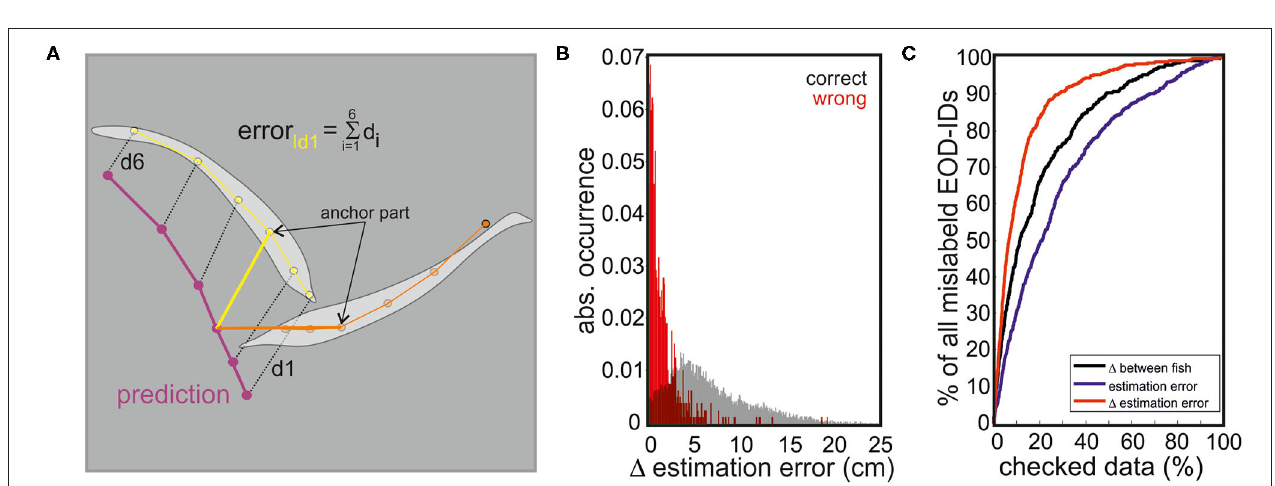
FIGURE 7 | (A) Estimation error calculation. The distance between each skeleton node of the predicted fish (based on the RFR) and the tracked fish (based on SLEAP) was measured. The predicted fish location that had the smallest sum of distances from either of the two tracked fish (estimation error) was considered as the EOD producing fish. (B) Histogram of correct (black) and incorrect (red) identity assignments as a function of the difference in estimation error of both fish (abs(errorID 1 -errorID 2 , red)). (C) We tested different parameters to assess the likelihood that the model erroneously assigned EODs to individuals. The first parameter used was the distance between individual fish (black), the second the estimation error (blue), and the third the difference between the estimation errors of both fish (red). The percentage of mislabeled EOD-IDs found during manual re-inspection of the data is plotted against the percentage of data that had to be checked for different measurements. Reading example: checking 5% of the data using a threshold criteria based on the difference between both fish resulted in a capture of 30% of all errors, or in other words the 5% of the data that had the smallest difference between both fish contained 30% of all mislabeled EODs. When checking 5% of the data using a threshold criteria relying on the estimation error alone allowed an identification of only 18% of all errors. However, when checking 5% of the data using the threshold criteria based on the difference in estimation error, 40% of all errors could be found. Hence, using the threshold criteria based on the difference in the estimation error is the most efficient way to find wrongly assigned EODs. Within the first 10 min after the first contact, a 5-min was determined by counting the number of attacks and video was recorded at 10 frames/second. This video was observing the chasing behavior from these videos. An used to evaluate the fight resolution. Fight resolution attack was defined as a contact between both animals